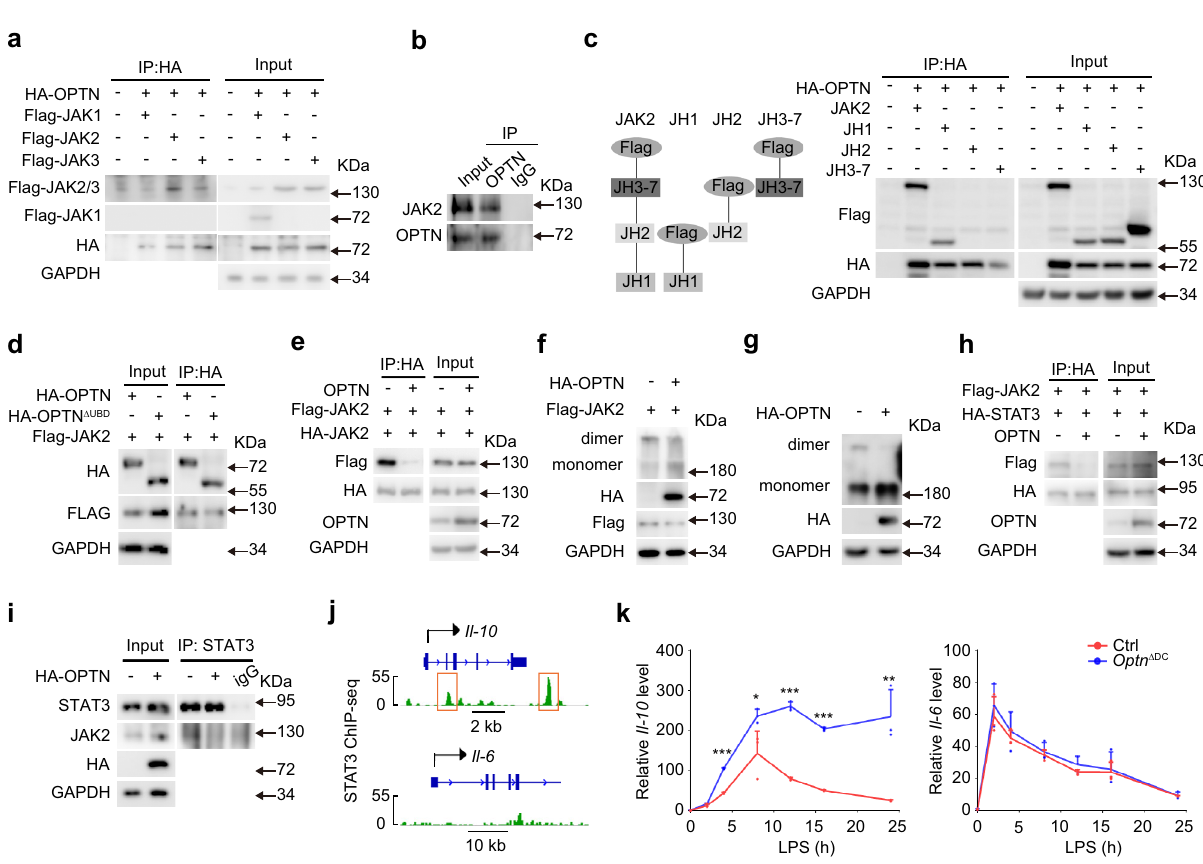
Fig. 7 OPTN inhibits the dimerization of JAK2 and subsequent STAT3 activation. a HA-OPTN expression plasmid was transfected with Flag-JAK1, Flag- JAK2, or Flag-JAK3 expression plasmid into HEK293 cells. Expression of OPTN and JAKs was con fi rmed by immunoblotting. Interaction between OPTN and JAKs was determined by immunoprecipitation (IP) with anti-HA antibody followed by immunoblotting with anti-Flag antibody. b Interaction between endogenous OPTN and JAK2 in BMDCs was analyzed by IP. c Schematic illustration of the truncated JAK2. Interactions between OPTN and truncation JAK2 in transiently transfected HEK293 cells were determined by IP. d Interactions between JAK2 with OPTN or OPTN Δ UBD in transiently transfected HEK293 cells were determined by IP. e Interactions between HA-JAK2 and FLAG-JAK2 in transiently transfected HEK293 cells was determined by IP. f , g HEK293 cells were transfected with FLAG-JAK2 and HA-OPTN or empty vector ( f ). BMDCs were transfected with HA-OPTN or empty vector ( g ). Whole- cell lysates were incubated with disuccinimidyl suberate (DSS). JAK2 antibody marked two bands: the upper band referring to the dimer and the lower band representing the monomer of JAK2. h Interaction of FLAG-JAK2 and HA-STAT3 in transiently transfected HEK293 cells was determined by IP. i BMDCs were transfected with HA-OPTN or empty vector. Interaction between endogenous STAT3 and JAK2 in BMDCs was analyzed by IP. j ChIP-seq analysis of the binding between STAT3 and Il-10 or Il-6 from GSE27161. k Il-10 and Il-6 mRNA level in Ctrl and Optn de fi cient BMDCs stimulated with LPS for different times. n = 3 independent experiments, P (4) = 3.2E − 06, P (8) = 0.0497, P (12) = 1.2E − 05, P (16) = 3.9E − 07, P (24) = 0.0060 of Il-10 . Data in ( a – i ) are representative of three independent experiments. Data are presented as means± SD. * P < 0.05; ** P < 0.01; *** P < 0.001. Unpaired two-tailed Student ’ s t -test. Source data are provided in Source data fi